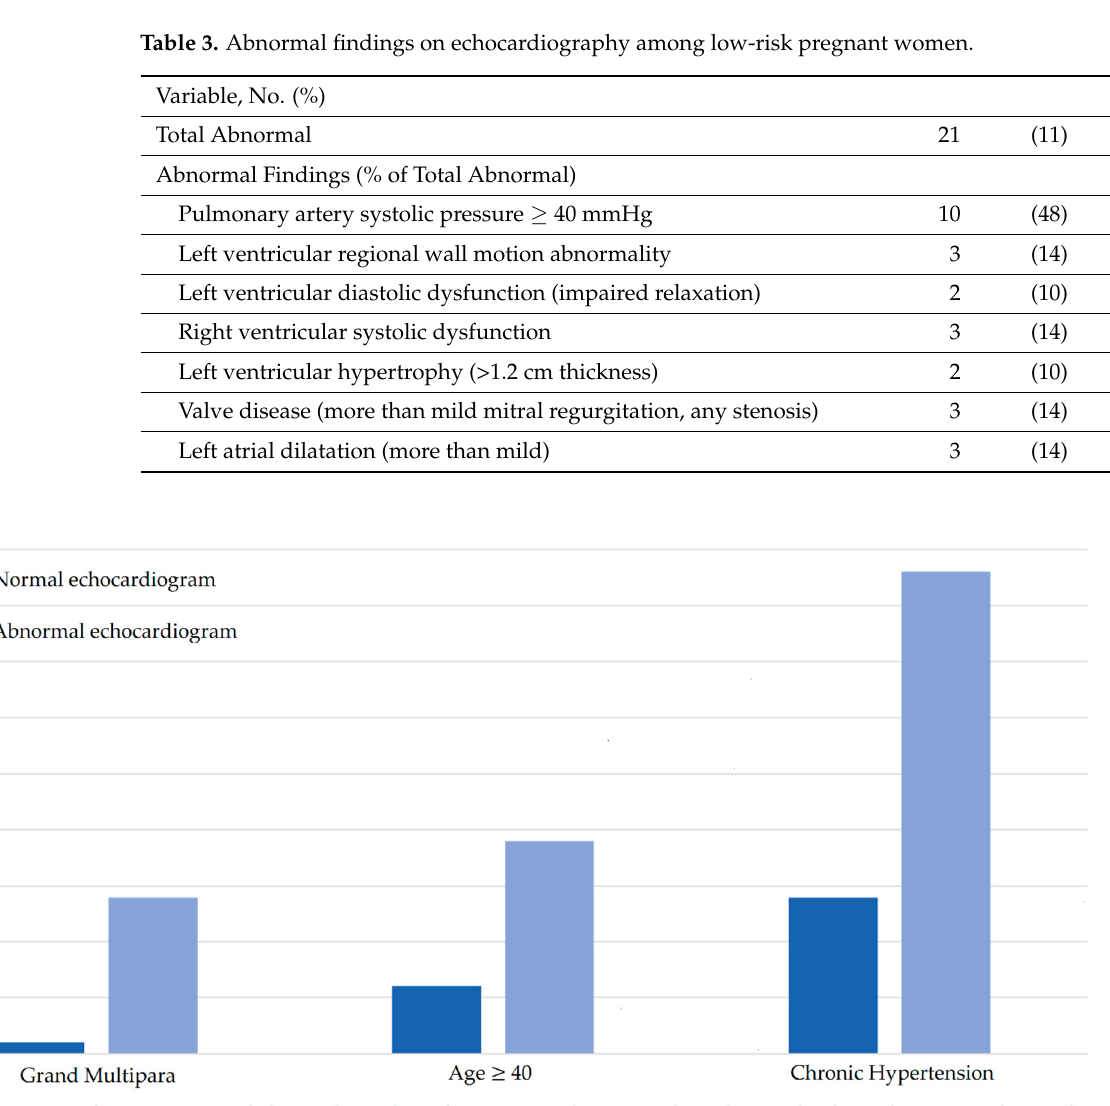
Figure 1. Percentage of normal and abnormal echocardiograms by grand multipara, age, and hypertensive status.